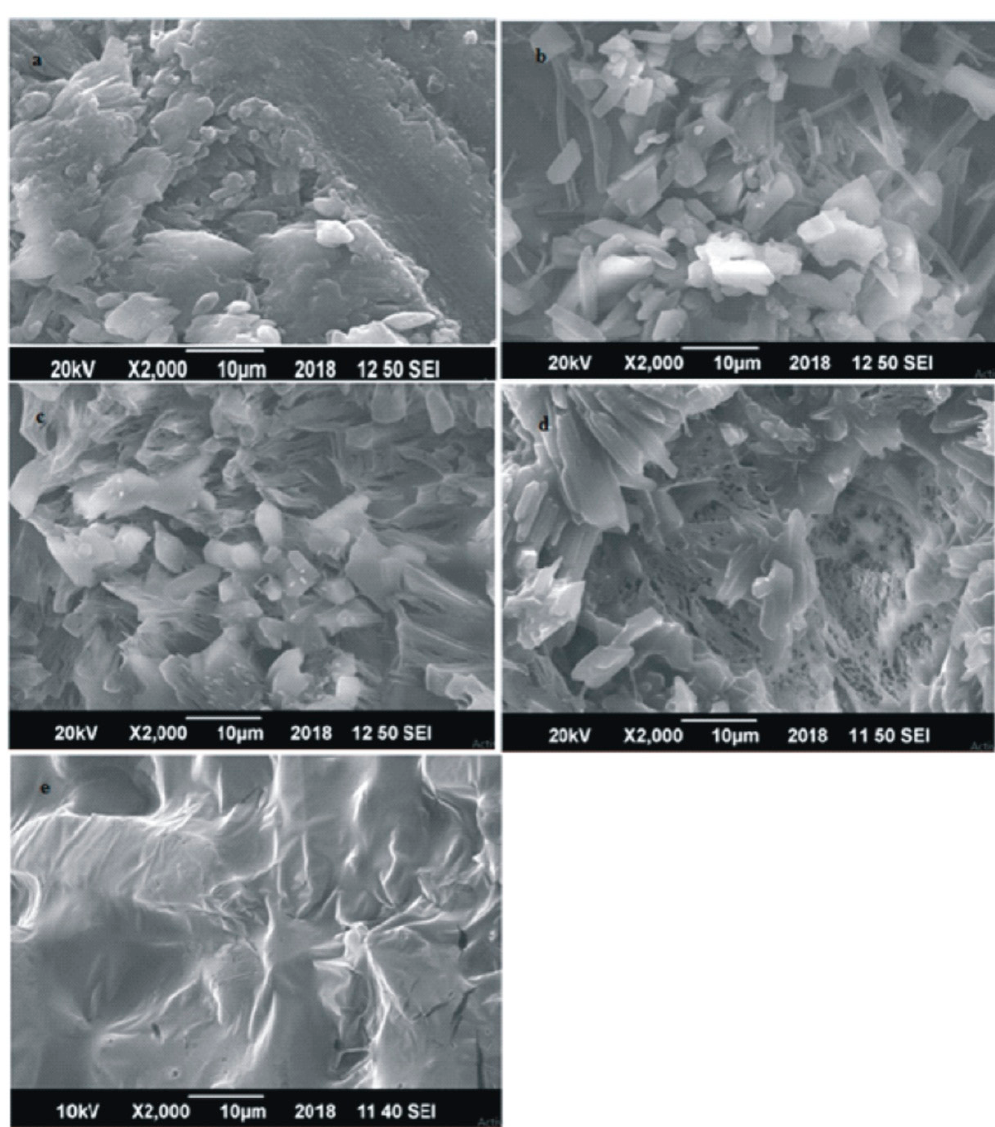
Figure 1. Scanning electron microscopy micrographs of granular urea: ( a ) G-0: Uncoated, and coated Figure 1. SEM micrographs of granular urea: ( a ) G-0: Uncoated, and coated with ( b ) G-1: 10% starch + with ( b ) G-1: 10% starch + 5% polyvinyl alcohol (PVA) + 5% molasses; ( c ) G-2: 10% starch + 5% PVA 5% polyvinyl alcohol (PVA) + 5% molasses; ( c ) G-2: 10% starch + 5% PVA + 5% para ffi n wax (PW); + 5% paraffin wax (PW); ( d ) G-3: 5% gelatin + 10% gum arabic + 5% PW; ( e ) G-4: 5% molasses + 5% ( d ) G-3: 5% gelatin + 10% gum arabic + 5% PW; ( e ) G-4: 5% molasses + 5% gelatin + 10% gum gelatin + 10% gum arabic.